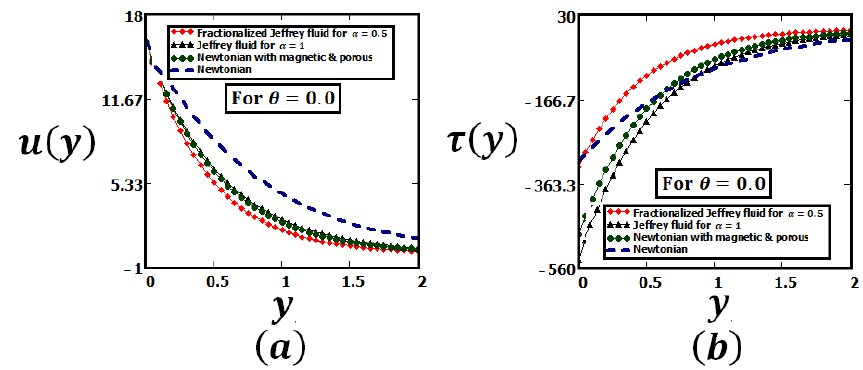
Figure 13: Profiles of the velocity field u ( y , t ) and the shear stress τ ( y , t ) for fractionalized & ordinary Jeffrey fluid given by Eqs. (16) and (21), Newtonian fluid with MHD & parous and Newtonian fluid given by Eqs. (32) and (33) for A = 1, ν = 1.427, µ = 19, λ 0.5, K = 2, α = 0.5, θ = 0.0, p = 4 and t = 2 s